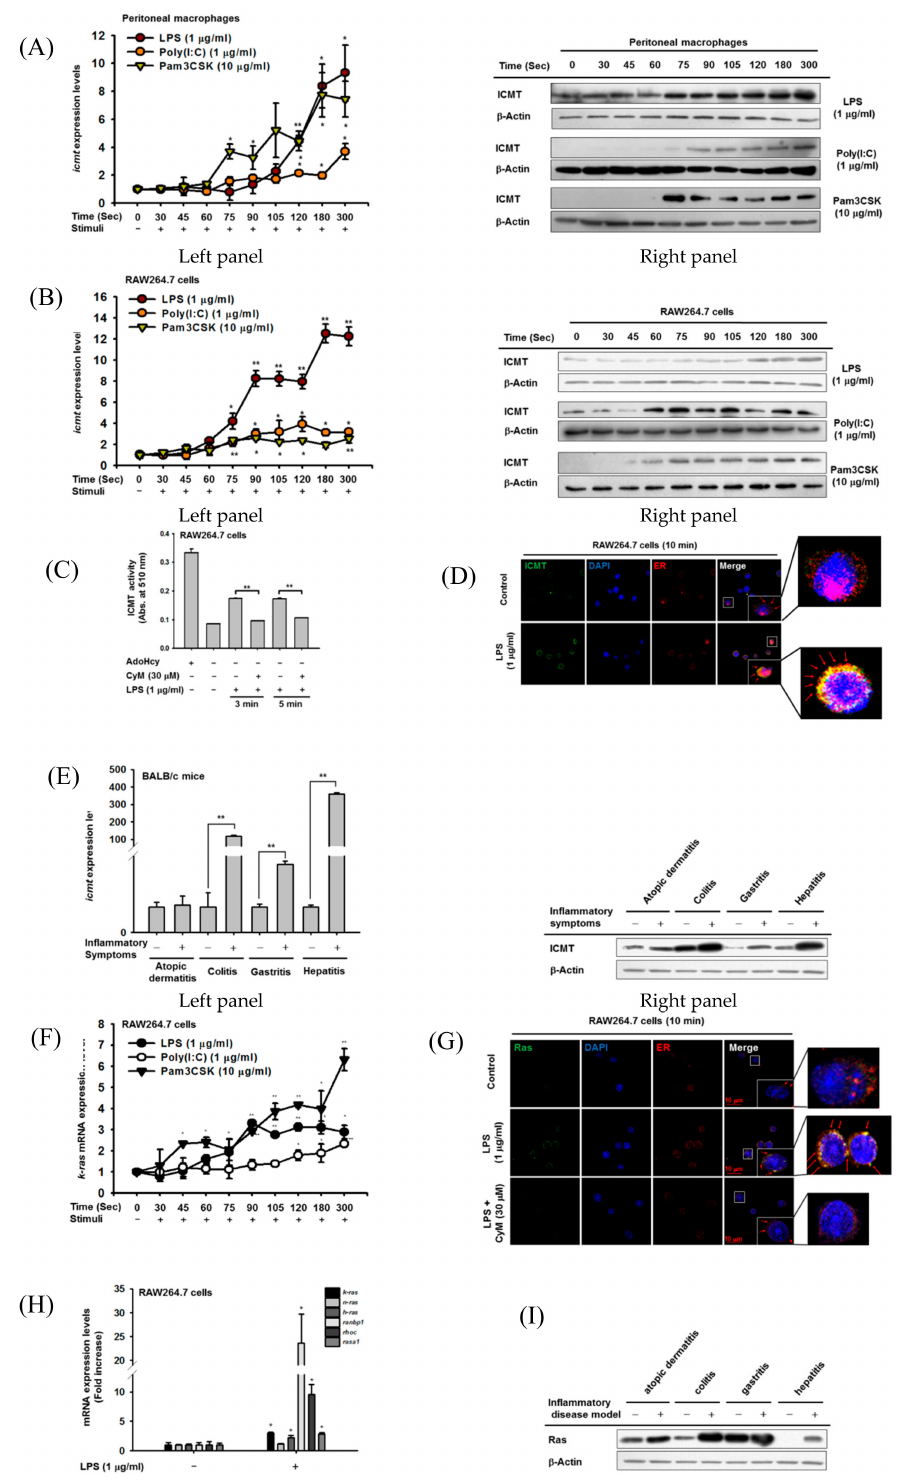
Figure 1. ICMT is highly expressed in chronic inflammatory conditions and TLR-mediated macrophage activation